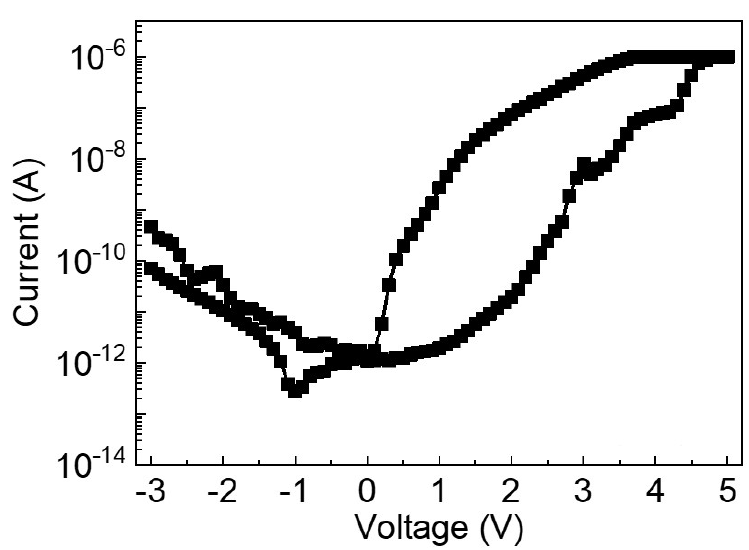
Figure 7. I-V characteristics of 3-D VRRAM cell.